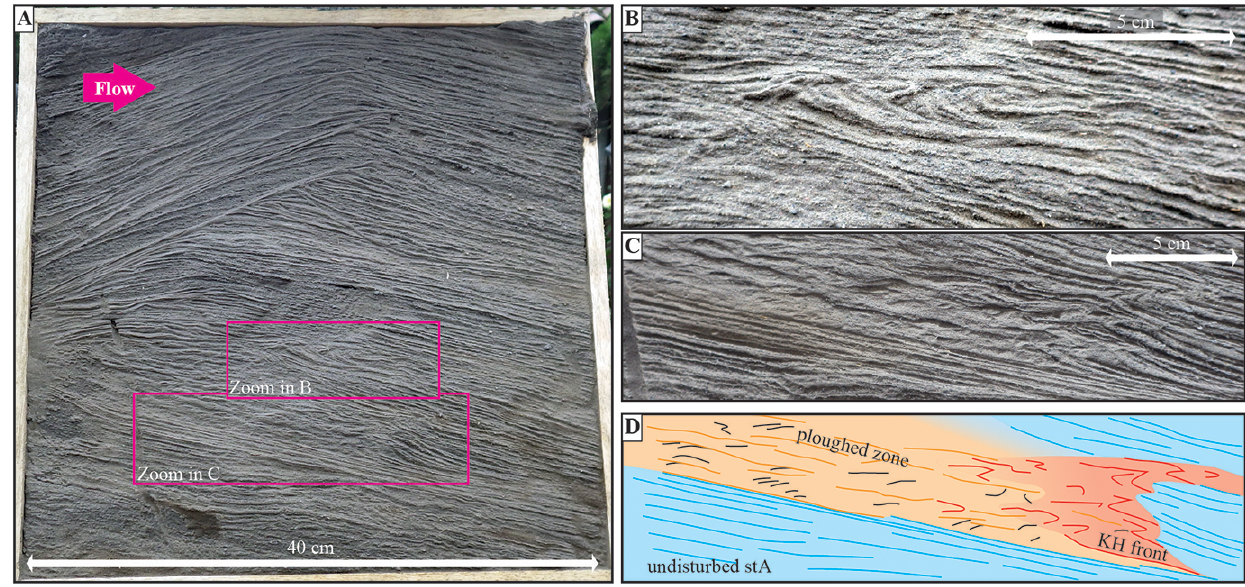
Figure 2. Overturned laminations from Tungurahua in the Achupashal valley (see Douillet et al., 2013a) illustrating shear in a granular BBL (imprint from lacquer peel). (a) Peel showing stoss-depositional ash bed sets, insets highlight the borders of (b) and (c) . (b) Imbricated, downflow-recumbent, vortex-shaped SSD structure. Panels (c) and (d) show recumbent and tailing overturned laminae form a front of deformation. The zone upstream the front contrasts with the downstream undisturbed bedding: it is comparatively massive, with thick beds and diffuse oversteepened stratification attributed to the ploughing effect of the downstream moving shear instabilities from the deformation